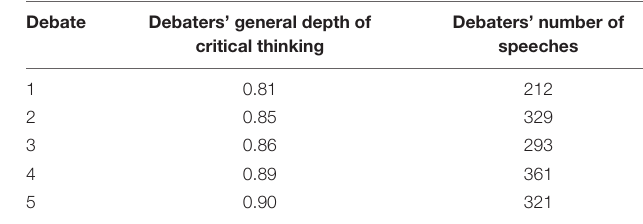
TABLE 3 | Murphy’s phrases of critical thinking framework (Murphy, 2004). TABLE 4 | Debaters’ depth of critical thinking and their number of speeches in five debates.